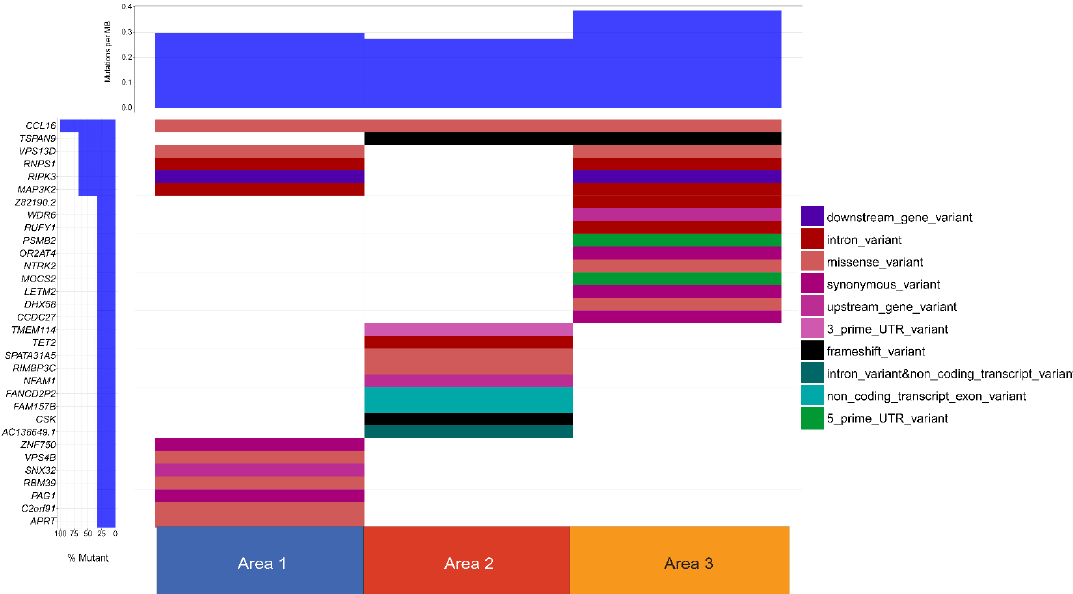
Figure 6. Somatic Variant Waterfall Plot. All somatic variants displayed on a waterfall plot. Each row represents a gene. Distinct somatic variant signatures are appreciated.